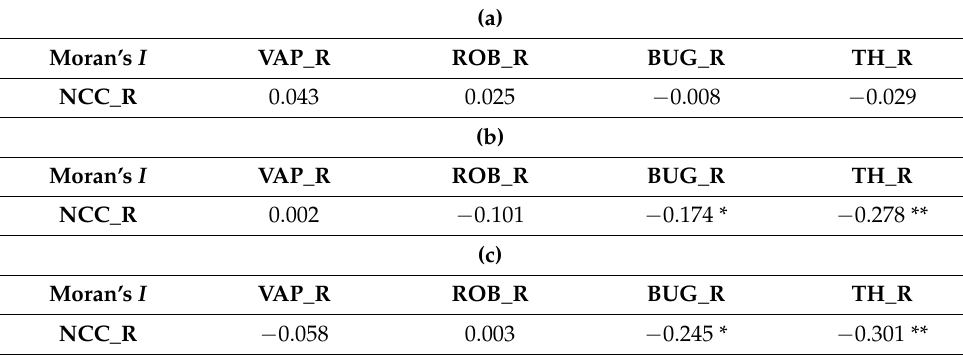
Table 4. Bivariate Moran’s I test of COVID-19 infection rate and crime rate for three months. ( a